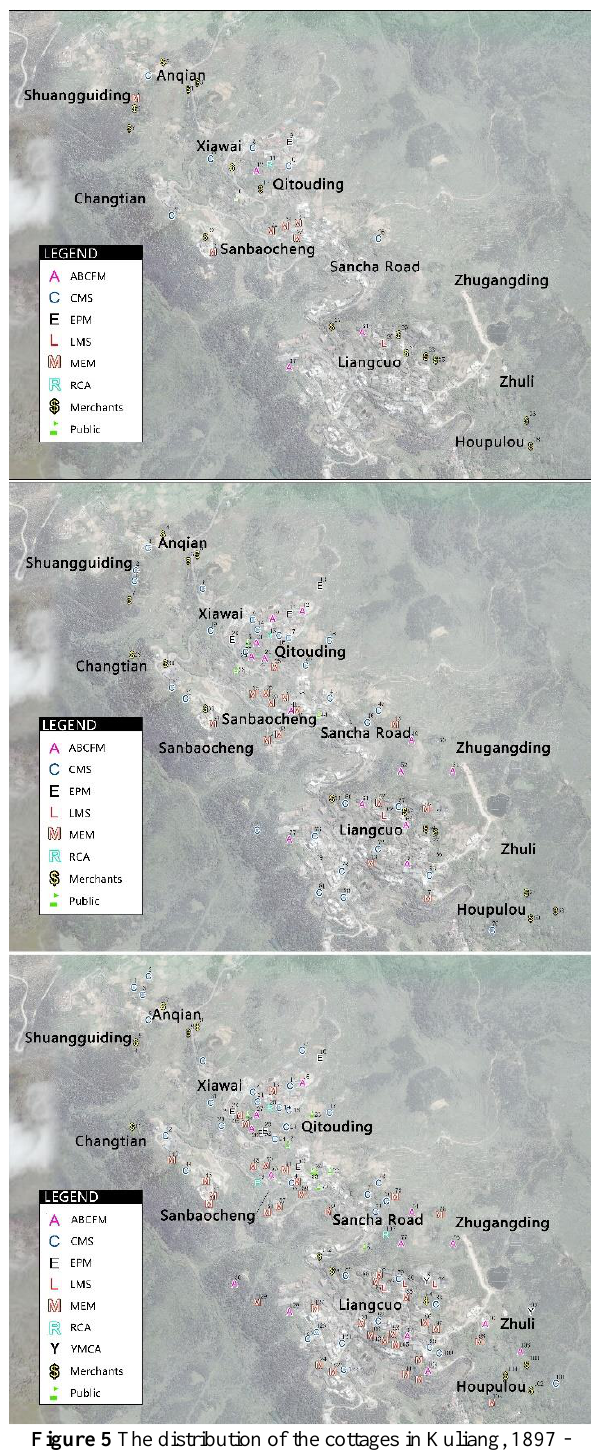
Figure 5 The distribution of the cottages in Kuliang, 1897 - 1907 - 1919. The ownership of the cottages was marked and showed the gathering pattern of the different missions on the